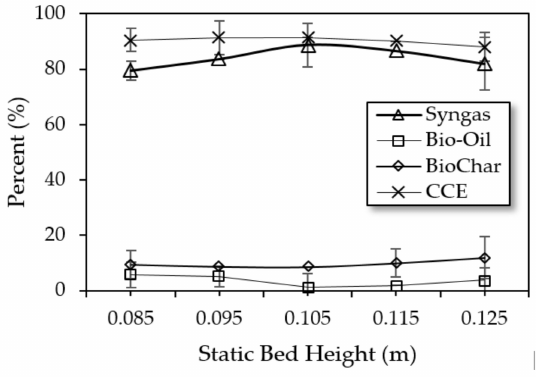
Figure 12. The e ff ect of SBH on gasification performance and e ffi ciency.